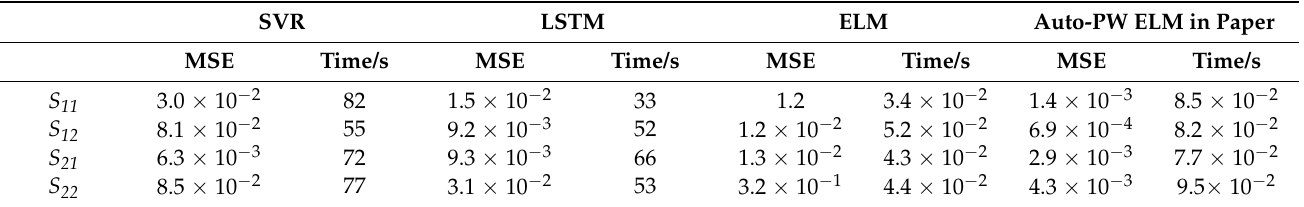
Table 1. Modeling accuracy of different models in terms of SVR, LSTM, ELM, and Auto-PW ELM. SVR